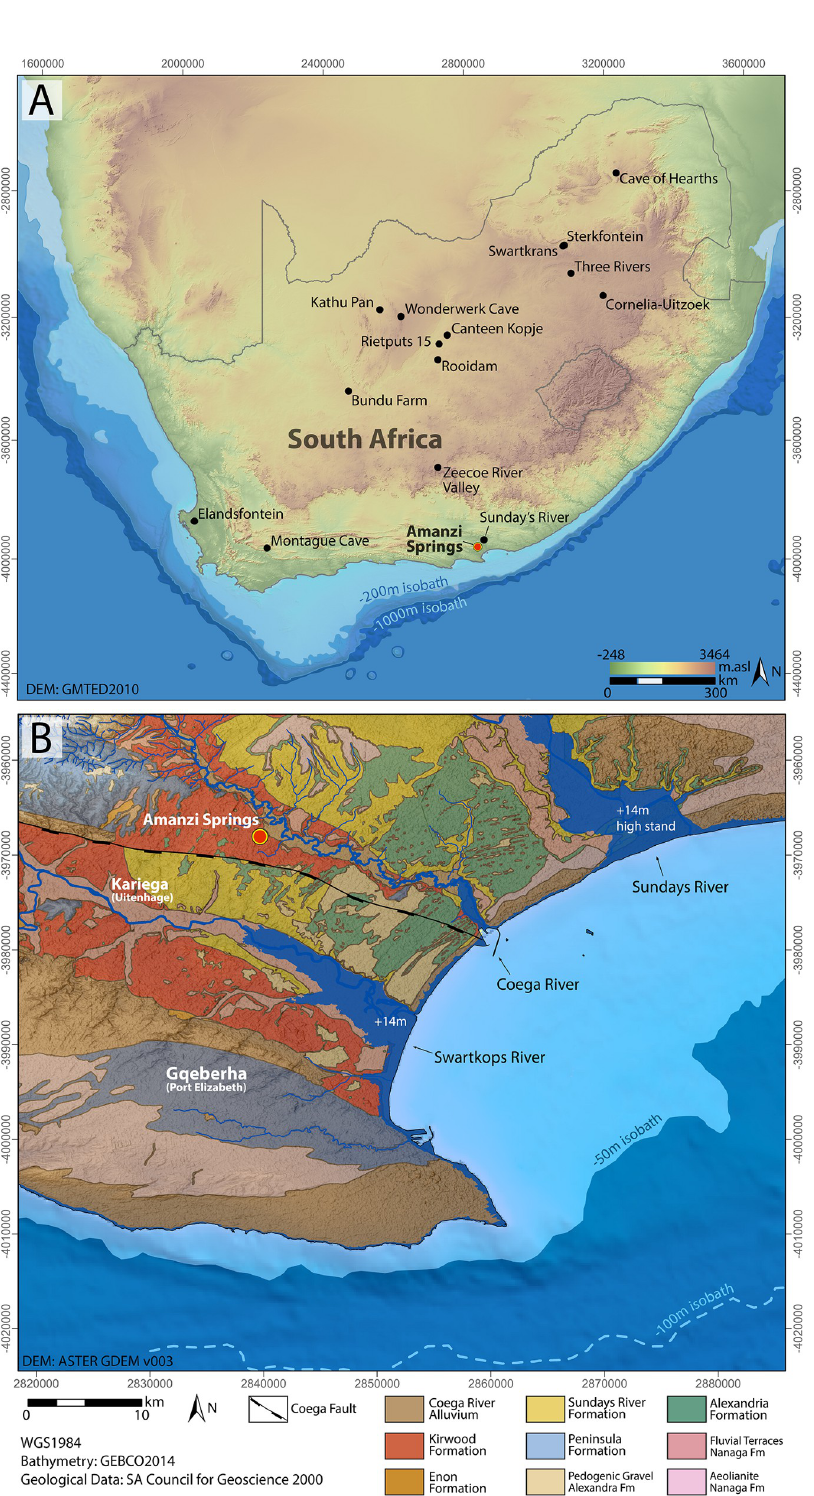
Fig 1. Location of Amanzi Springs. A) compared to other sites mentioned in the text; B) compared to the coastline today, during MIS 11 (+14m) and at the height of glacial periods (-100 to -120m). The Figure was created using open access data sources from